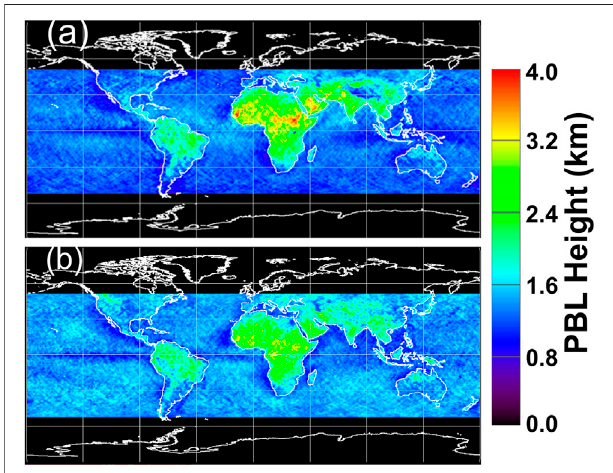
FIGURE 10 | Average PBL height derived from the analysis of all CATS 2016 night granules using the CNN algorithm (A) and threshold algorithm (B) .